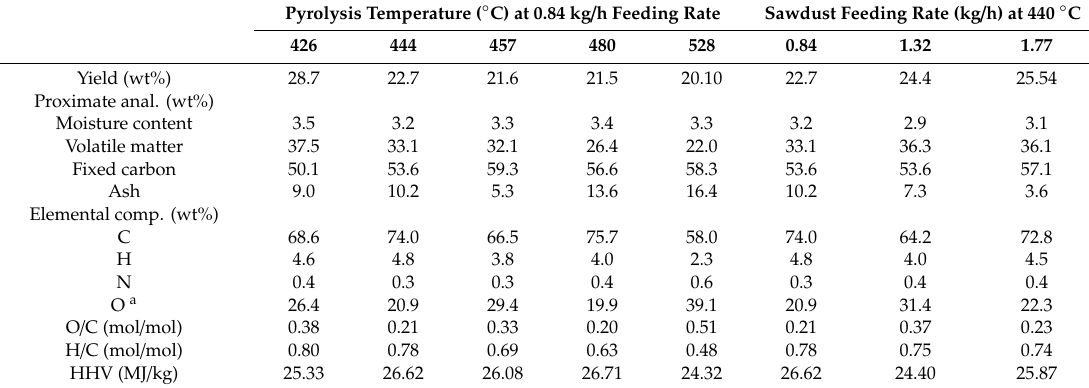
Table 4. E ff ect of pyrolysis temperature and feeding rate on the fuel characteristics of the reactor bottom